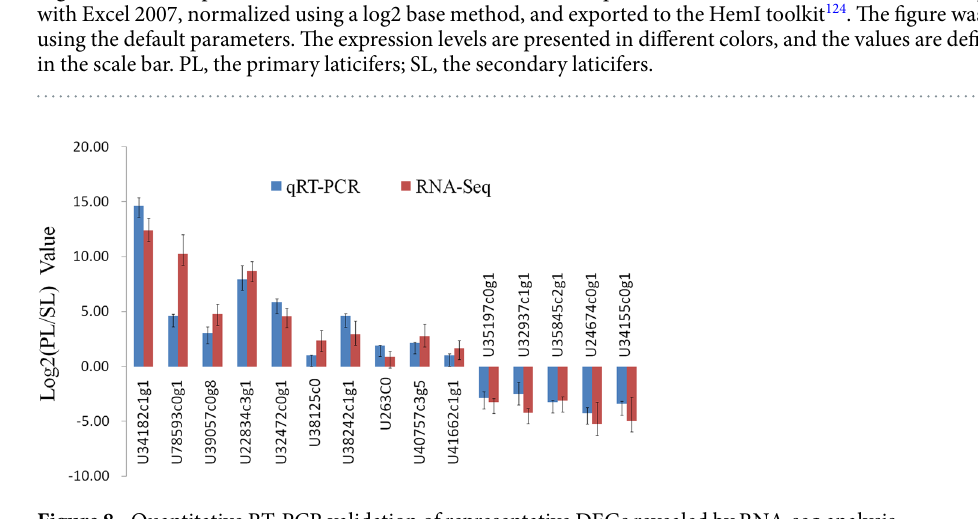
Figure 8. Quantitative RT-PCR validation of representative DEGs revealed by RNA-seq